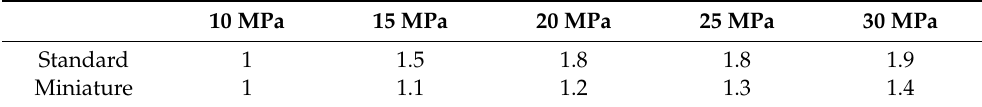
Figure 6. Longitudinal sections of crept standard samples, microstructure at different mechanical loads, ( a ) 10 MPa, ( b ) 15 MPa, ( c ) 20 MPa, ( d ) 30 MPa. Table 5. Aspect ratios of elongated